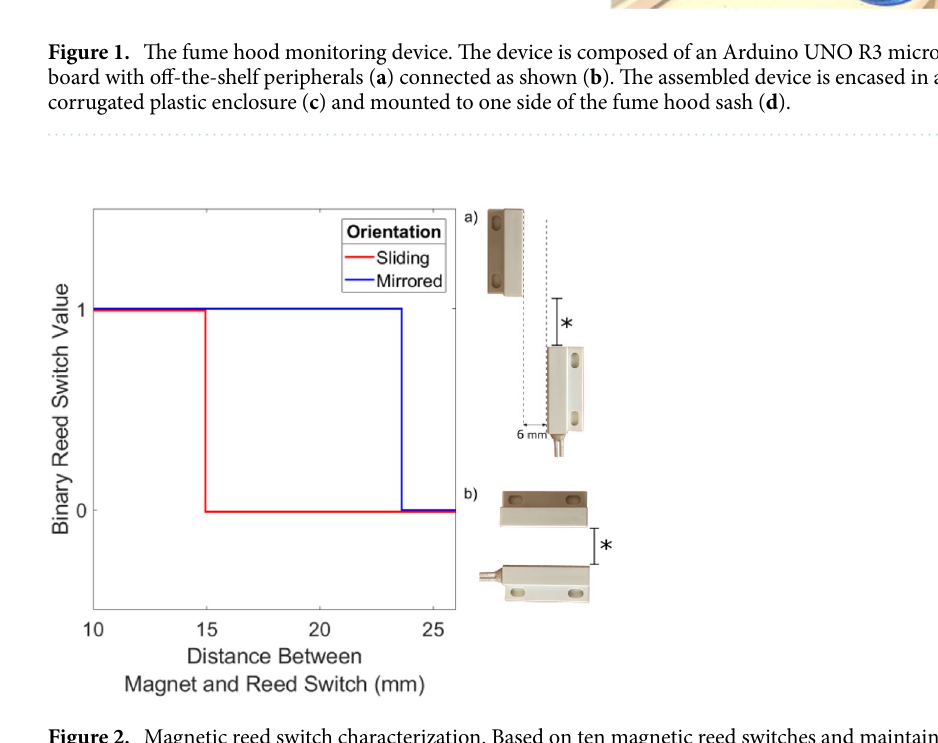
Figure 2. Magnetic reed switch characterization. Based on ten magnetic reed switches and maintaining a 6 mm clearance in the mirrored case, the hood sash is reported to be closed at a separation distance of 15.0 mm in the sliding case ( a ), and 23.6 mm in the mirrored orientation ( b